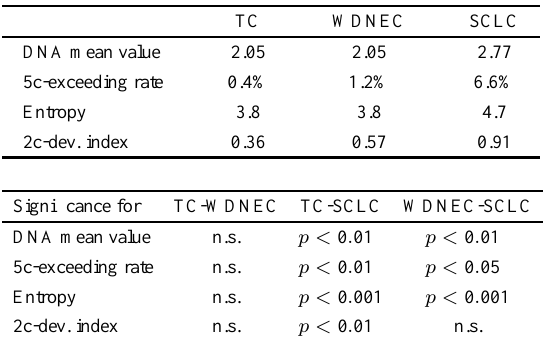
DNA-parameters: mean values and